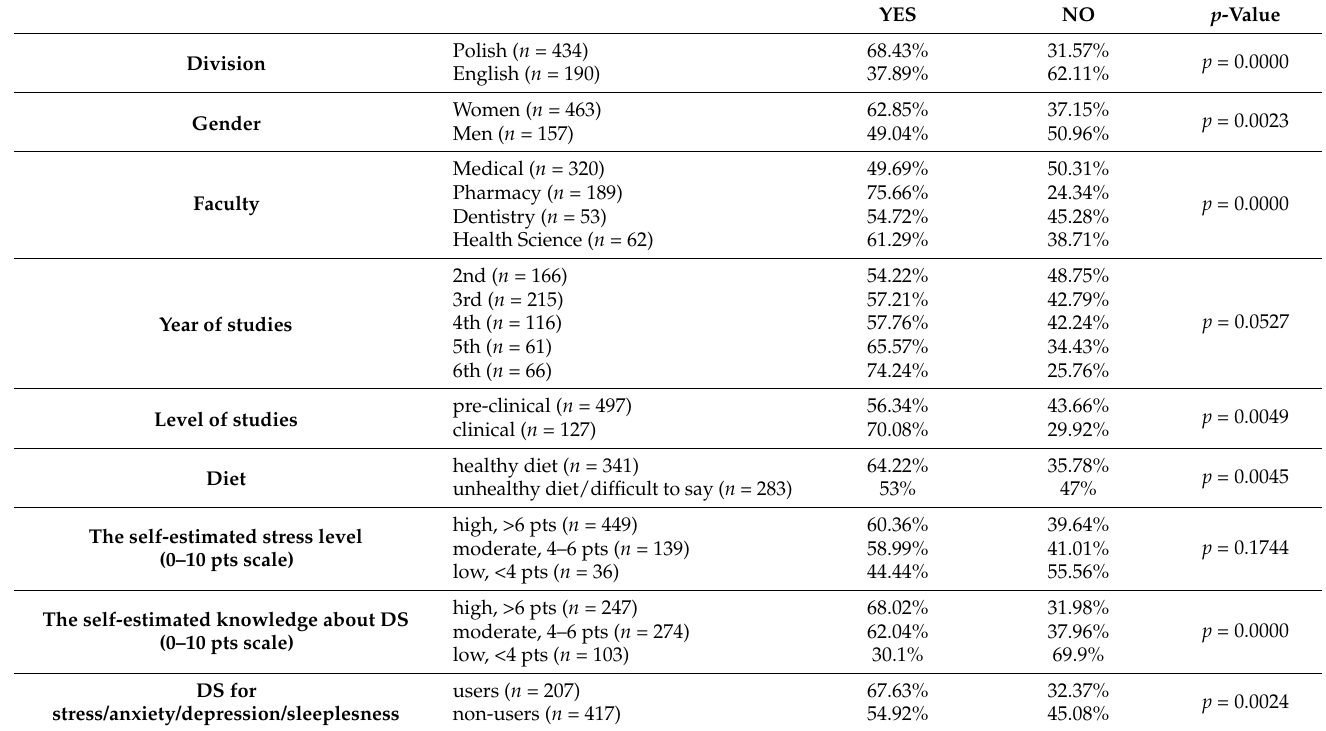
Table 4. The use of dietary supplements OTHER than for stress, anxiety, depression, or sleeping problems among Wroclaw Medical University students in the academic year 2020/2021. Analyses were performed using the chi-square